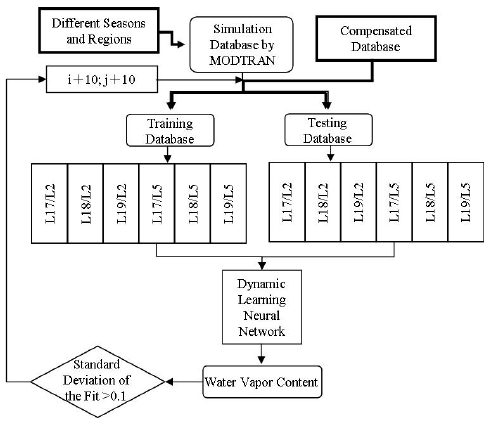
Figure 1. An advanced scheme for RM-NN.